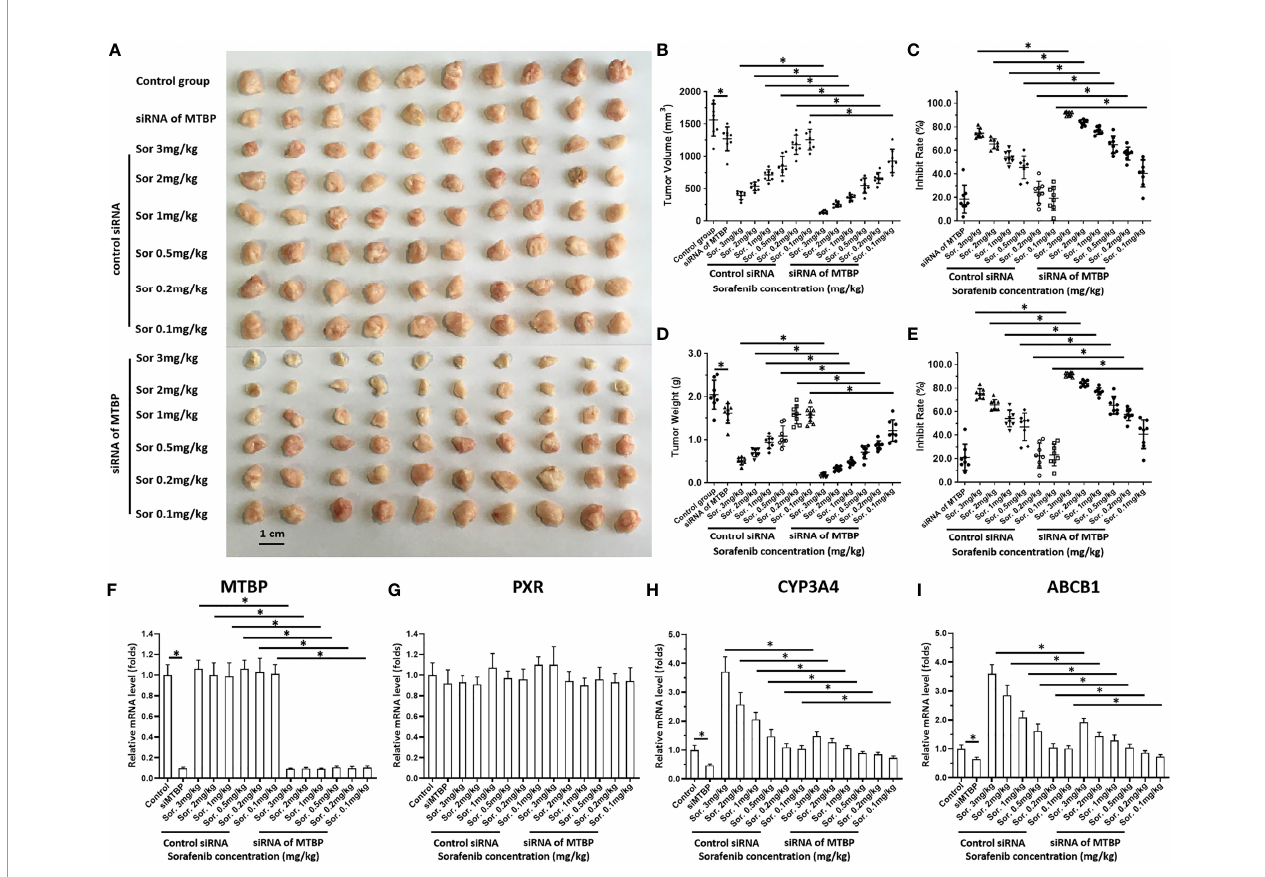
FIGURE 6 | MTBP decreased the antitumor effect of sorafenib on the subcutaneous growth of HCC cells. MHCC97-H cells were cultured and transfected with a control siRNA or the siRNA of MTBP. Cells were injected into mice to form subcutaneous tumor tissues and the mice received sorafenib treatment via oral administration. The mice were harvested and the tumor tissues were collected. The results were shown as the images of tumor tissues (A) , tumor volumes (B) , inhibition rates of sorafenib calculated by tumor volumes (C) , tumor weights (D) or inhibition rates of sorafenib calculated by tumor weights (E) . (F – I) the expression level (the mRNA level) of MTBP (F) , PXR (G) , cyp3a4 (H) or abcb1 (I) in subcutaneous tumors (A) was examined by qPCR and shown as the scatter-plot images (F – I) . *P <